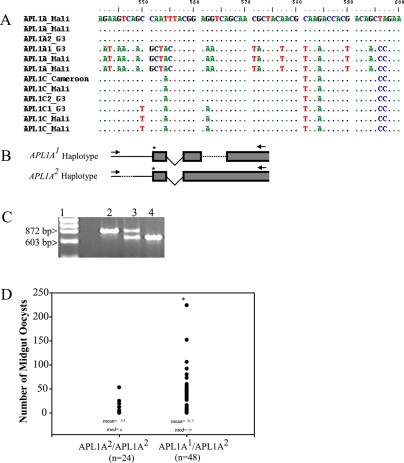
A. APL1 alleles are comprised of blocks of linked SNPs. Nucleotide alignment shows APL1A and APL1C genetic variation in a sample of A. gambiae wild and colony mosquitoes. Haplotypes are shared over the resequenced region between individual mosquitoes, indicating that the variants are stable haplotypes that exist in A. gambiae at appreciable frequency. B. Genotyping assay for segregating indels in the APL1 locus. A PCR assay was designed to test the state of 2 indels in APL1A that are markers for allelic haplotypes at the APL1 locus. Arrows show forward and reverse primers used in the diagnostic assay, dashed lines indicate indels (located within exon 2 of APL1A1, and above the translation start in APL1A2), asterisk indicates the start codon of APL1A. C. Indel genotyping assay. A representative gel of PCR products from the indel diagnostic assay, lane 1, Lambda HindIII/PhiX HaeIII marker, lane 2, APL1A2 homozygote (854 bp), lane 3, a heterozygote with codominant bands, lane 4, APL1A1 homozygote (663 bp). D. APL1 locus haplotypes control distinct levels of protection from P. berghei infection. Homozygous APL1A2 mosquitoes were significantly less permissive for parasite development than APL1A1/APL1A2 heterozygotes (asterisk, p<0.001, Mann Whitney Rank Sum Test; sample size (n), mean (mean), and median (med) given for each haplotype). Homozygous APL1A1 individuals are present at low frequency in the sampled colony and thus were not included in the analysis (see Results for further details on APL1A1 haplotype frequency).